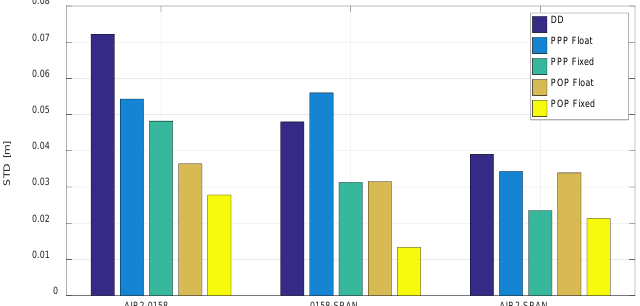
Figure 11. Statistics of the distances between the three antennas derived from the five types of solutions. It is seen that the POP fixed solutions generate the best baseline results.